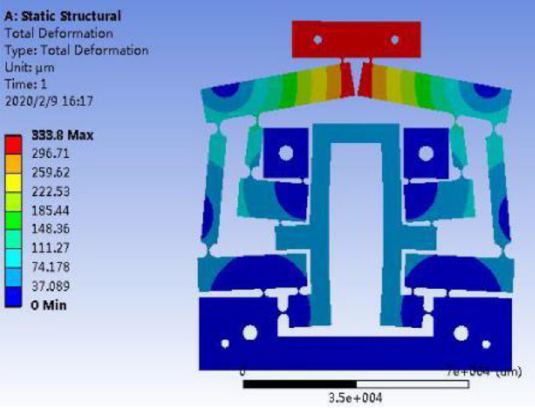
Fig. 7. Total deformation diagram of the